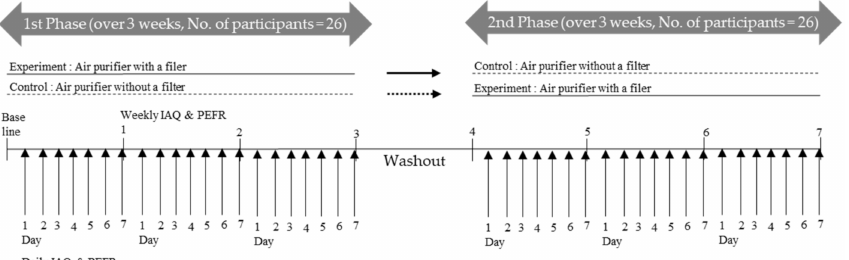
Figure 1. Randomized double-blind crossover intervention study design used in this study. Informed consent was approved by the research ethics committee of Inha Hospital. IAQ: indoor air quality; PEFR: peak expiratory flow